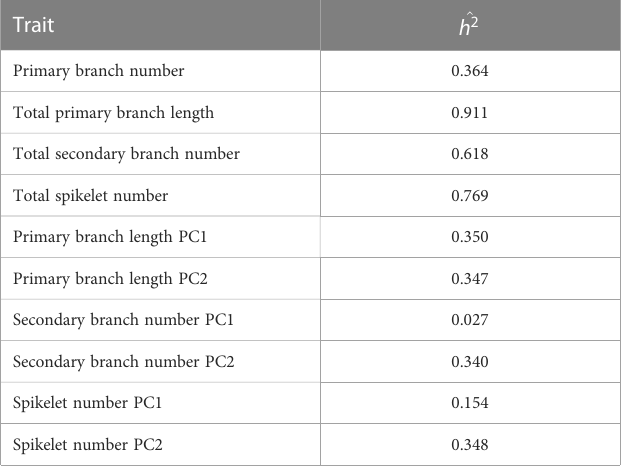
TABLE 2 Estimated narrow-sense heritability.